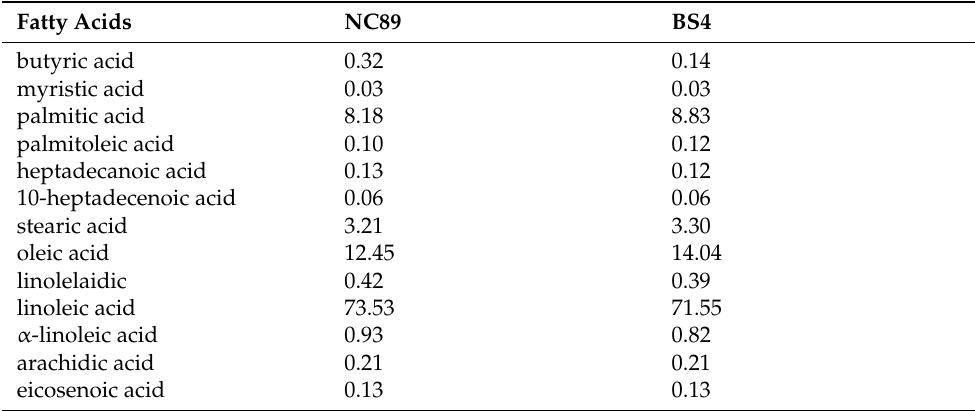
Table 3. Composition and relative contents of tobacco seed oil fatty acids